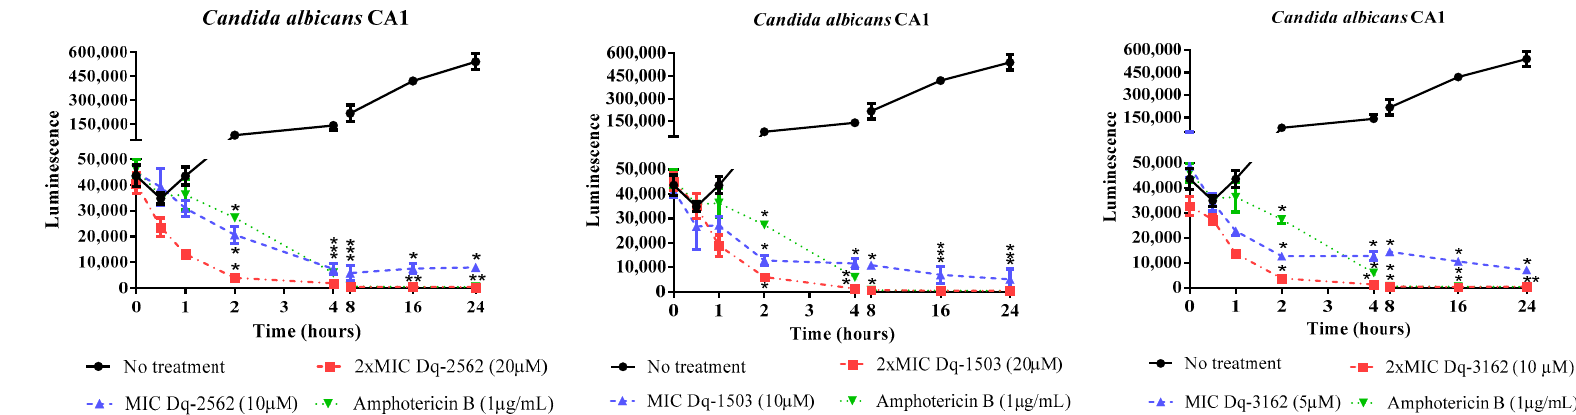
Figure 2. Effect of exposure time to synthetic pilosulin- (Dq-2562 and Dq-1503) and ponericin-like (Dq-3162) peptides from the giant ant D. quadriceps venom on the cell viability of amphotericin B- and fluconazole-resistant Candida albicans CA1. ANOVA and Tukey’s multiple comparisons test. * p < 0.05 (compared to untreated Candida cells).